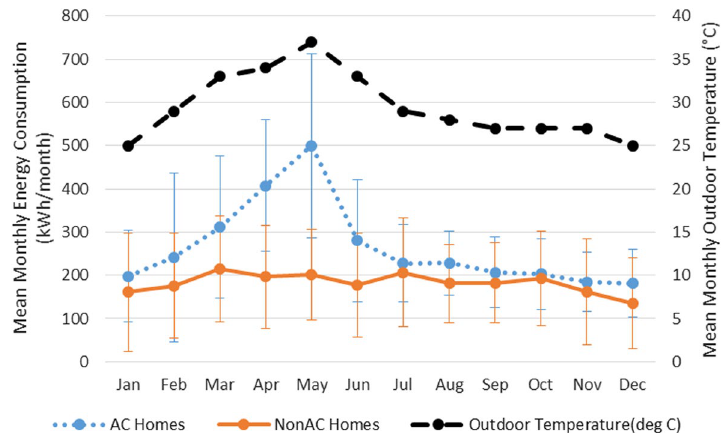
Table 3 Data considered for seasonal analysis Season Start date End